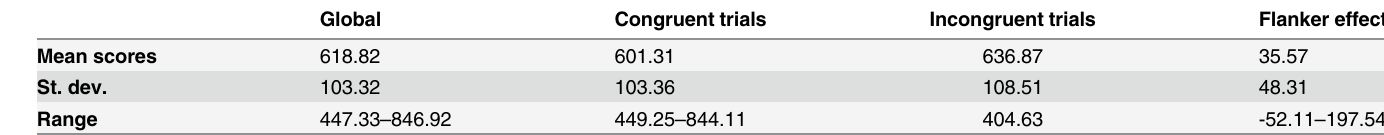
Table 11. Mean scores, standard deviations and ranges for the children ’ s reaction time on the Flanker task. Global